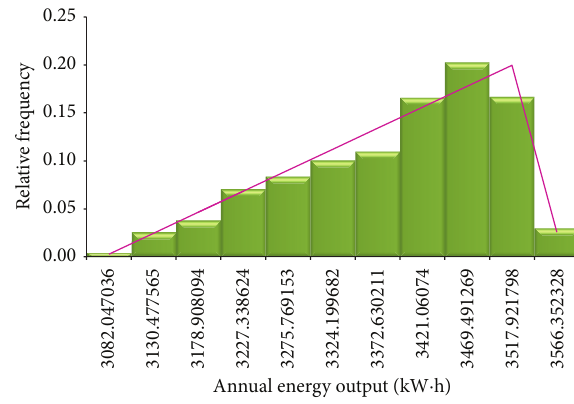
Figure 3: Monte Carlo simulation of relative frequency histogram for annual energy output.